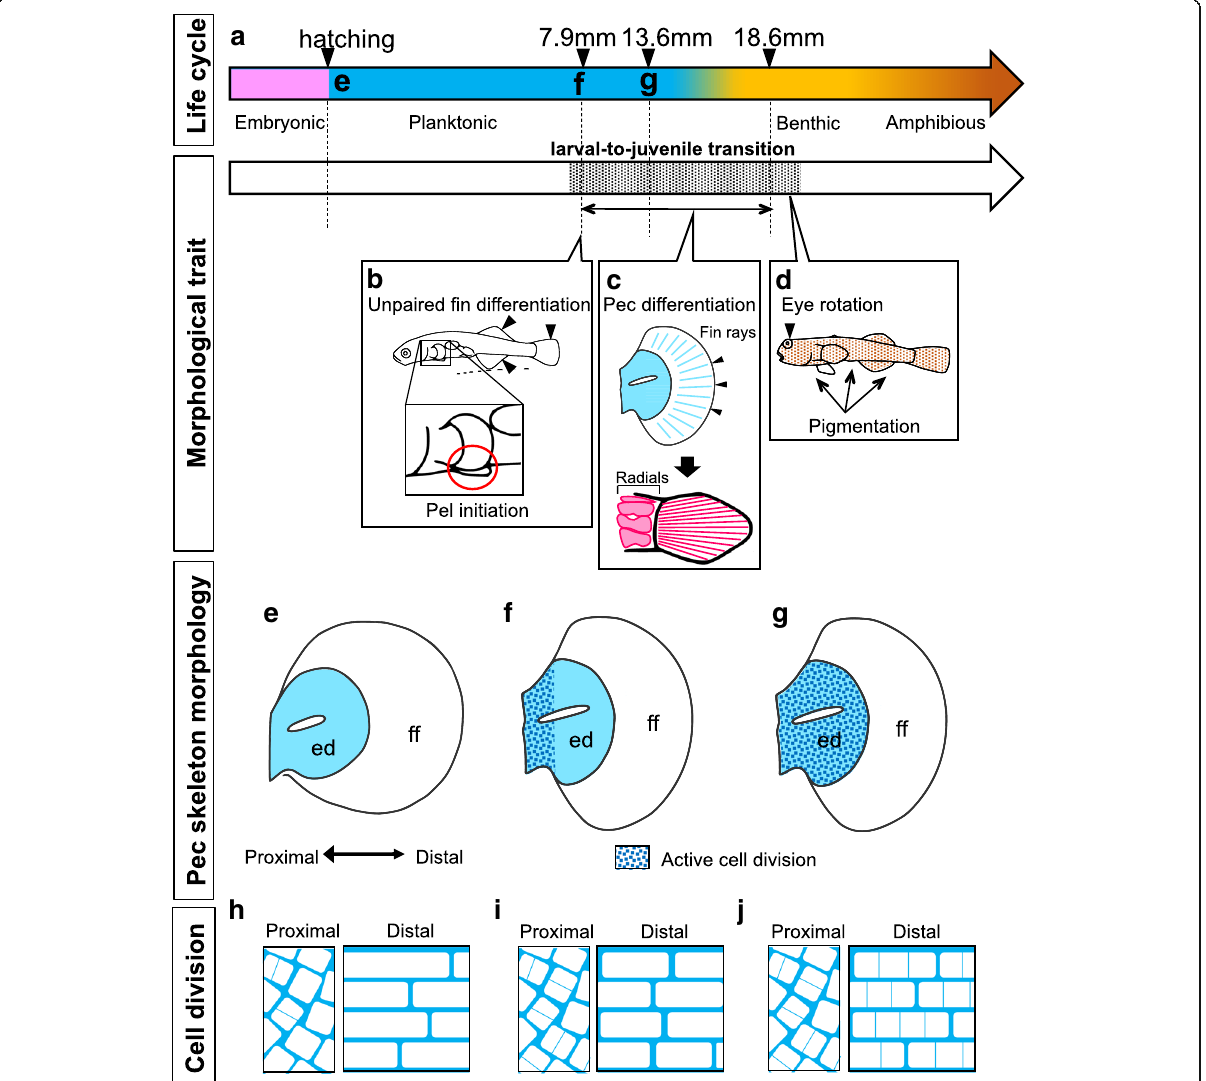
Fig. 7 Remodeling of the pectoral girdle and endoskeletal disc during the larva-to-juvenile transition. a Developmental stages of the mudskipper Ps. modestus . Pink, blue, yellow, and brown bars indicate embryonic, planktonic larval, benthic juvenile, and amphibious juvenile stages, respectively. The shaded region indicates the larva-to-juvenile transition. b – d Morphological changes observed during the larva-to-juvenile transition. Indicative metamorphic changes are observed during 7.9 mm to 18.6 mm TL, including differentiation of the median fin and initiation of pelvic fin bud formation during 7.9 mm TL ( b ); formation of 14 fin rays during 14.5 mm TL and their ossification, as well as individualization of proximal radials and their ossification during 18.6 mm TL ( c ); and the dorsal shift in eye position and dispersion of melanophores throughout the body during 18.6 mm TL ( d ). e – g Morphological changes in the endoskeletal disc at each stage indicated in ( a ). Blue dots indicate the region where active cell divisions are observed. ed., endoskeletal disc: ff, fin fold. h - j The shape and oriented division of chondrogenic cells of the endoskeletal disc within the pectoral fin. h At the beginning of the planktonic larval stage, round-shaped cells are found proximally, whereas cylindrical cells are aligned along the proximal-distal axis. i At the beginning of the larva-to-juvenile transition [10], cells are actively dividing in the proximal region, whereas in the distal region they are cylindrical in shape, only infrequently dividing, and aligned along the proximal-distal axis. j At the end of the larva-to-juvenile transition, the distal cylindrical cells are dividing actively along the proximal-distal axis. See text for